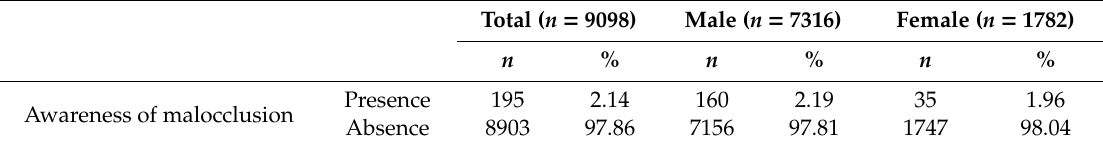
Table 1. The rate of an awareness of malocclusion among the study